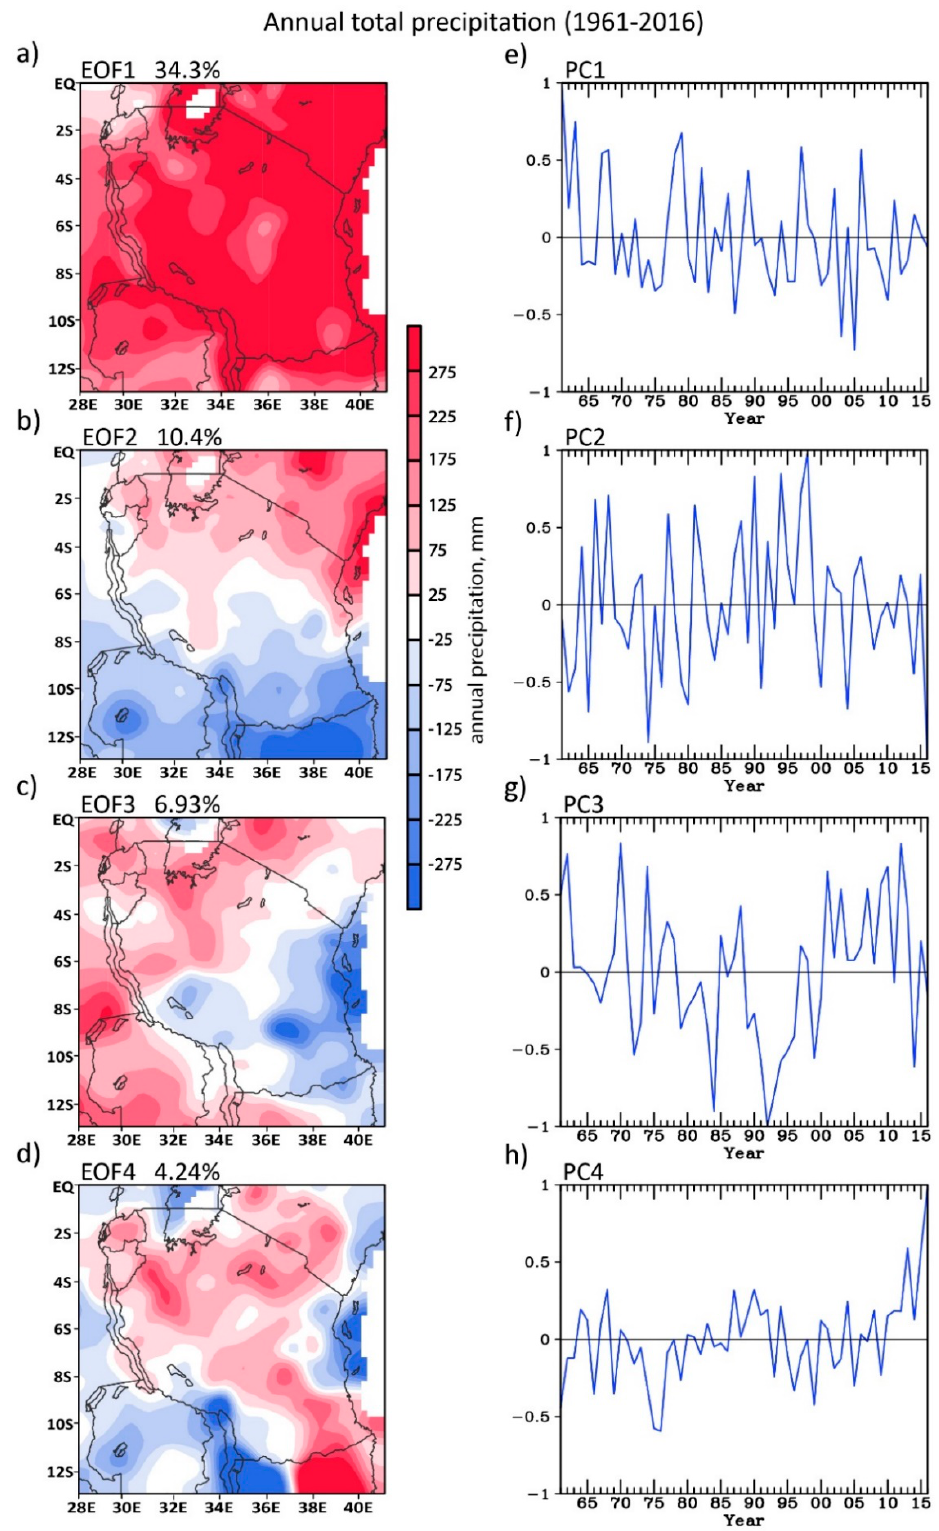
Figure 5. ( a–d ) First four modes of empirical orthogonal function (EOF) of annual precipitation over Tanzania and with their respective ( e–h ) principal components. Precipitation data are from Global Precipitation Climatology Centre (GPCC) for the period of 1961–2016. Precipitation is in mm.